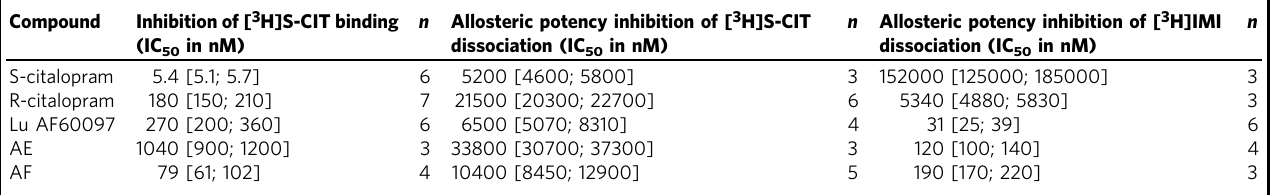
Datafor[ 3 H]S-CITbindinginhibitionareobtained bynon-linear regressionanalysisof competitionbindingexperimentsbetween[ 3 H]S-CITandincreasingconcentrationsof the indicatedcompound(10 concentrations in triplicates). Allosteric potencies are the IC 50 from non-linear regression analysis of the change in dissociation rate constant relative to no compound present ( k [cmpd] / k buffer ) as a function of the added compound concentration (Log[cmpd]). Experiments performed on membrane preparations of COS-7 cells expressing SERT WT. Data are shown as mean [SE interval] and are calculated from pIC50 and the SE interval from